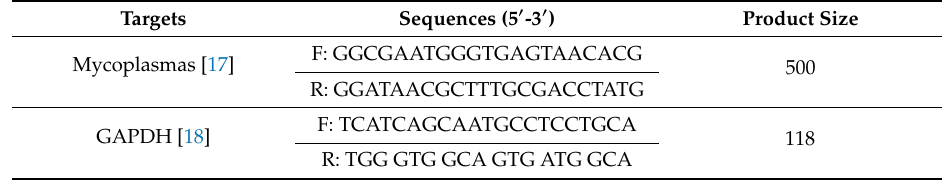
Table 1. Nucleotide sequence of mycoplasma universal